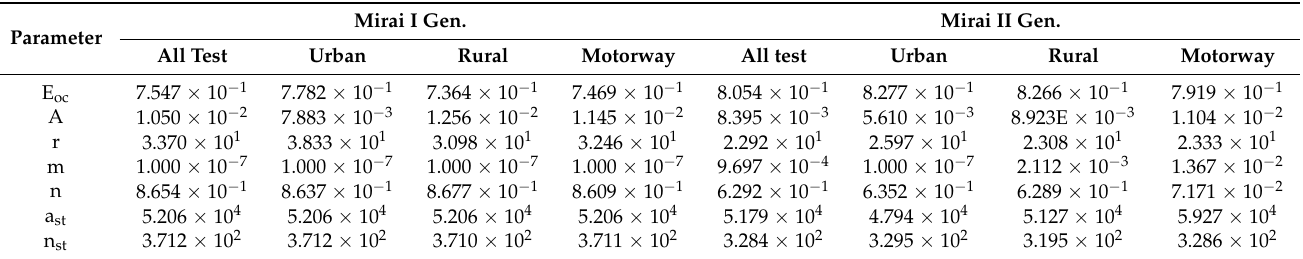
Table 4. The results of the fuel cell stack modeling study. Mirai I Gen. Mirai II Gen.